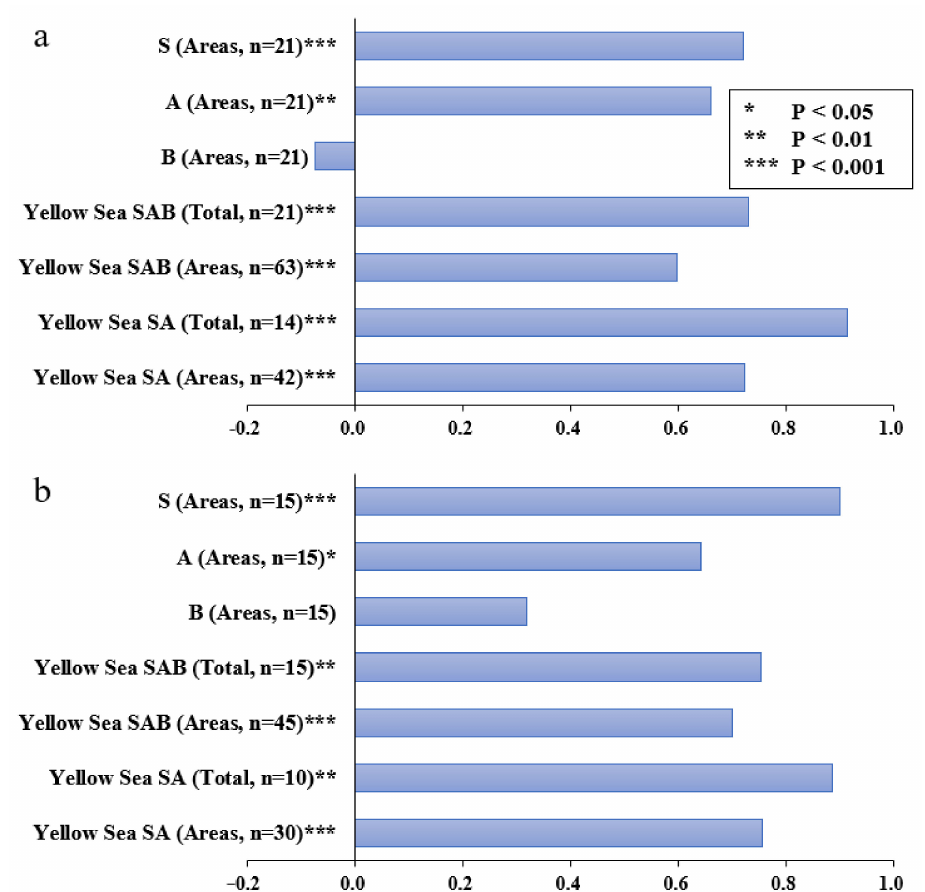
Figure 5. Shape correspondence analysis of SAB patterns between ISEP grades and the categories reflecting the stress gradient in P-R model, performed individually (S, A, and B, respectively) and at integrated levels (SAB or SA excluding biomass). Seven ISEP grades ( a ), and five grades ( b ). Based on the conformity of the ISEP grades to the P-R model, the ISEP grades were categorized into characteristic zones, as explained in the Materials and Methods